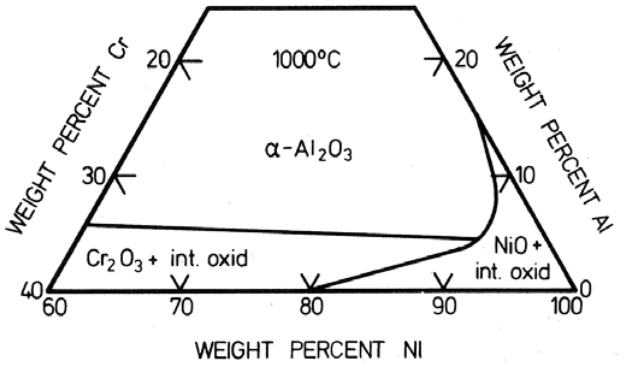
Figure 5. Oxide map for alloys in the Ni-Cr-Al system delineating the composition ranges for formation of different types of oxide scales